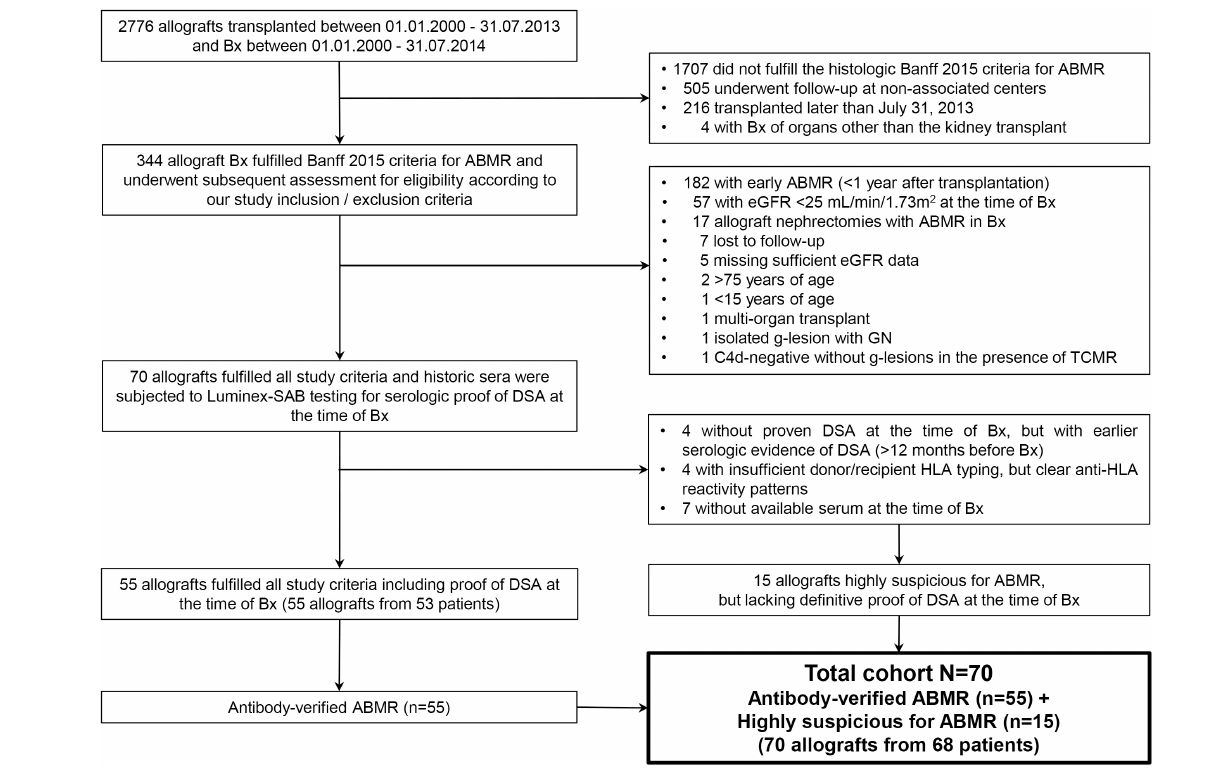
FIGURE 1 | Flowchart of the biopsy and patient selection process. After strictly applying all inclusion and exclusion criteria historical sera were searched for in order to carry out collective SAB testing as some biopsies dated back until the year 2000, long before Luminex testing was available at our center. The total cohort consisted of 70 biopsies from 68 patients (two biopsies came from repeat kidney transplants from the same two